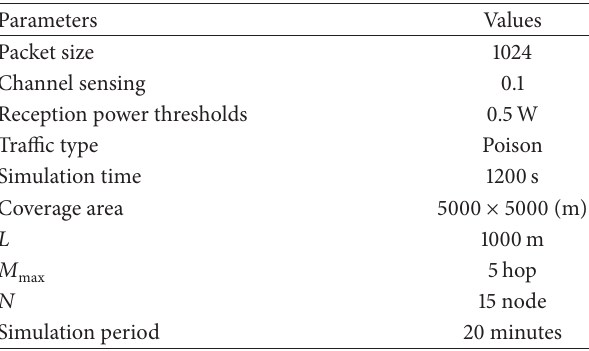
Table 1: Simulation settings and configurations.